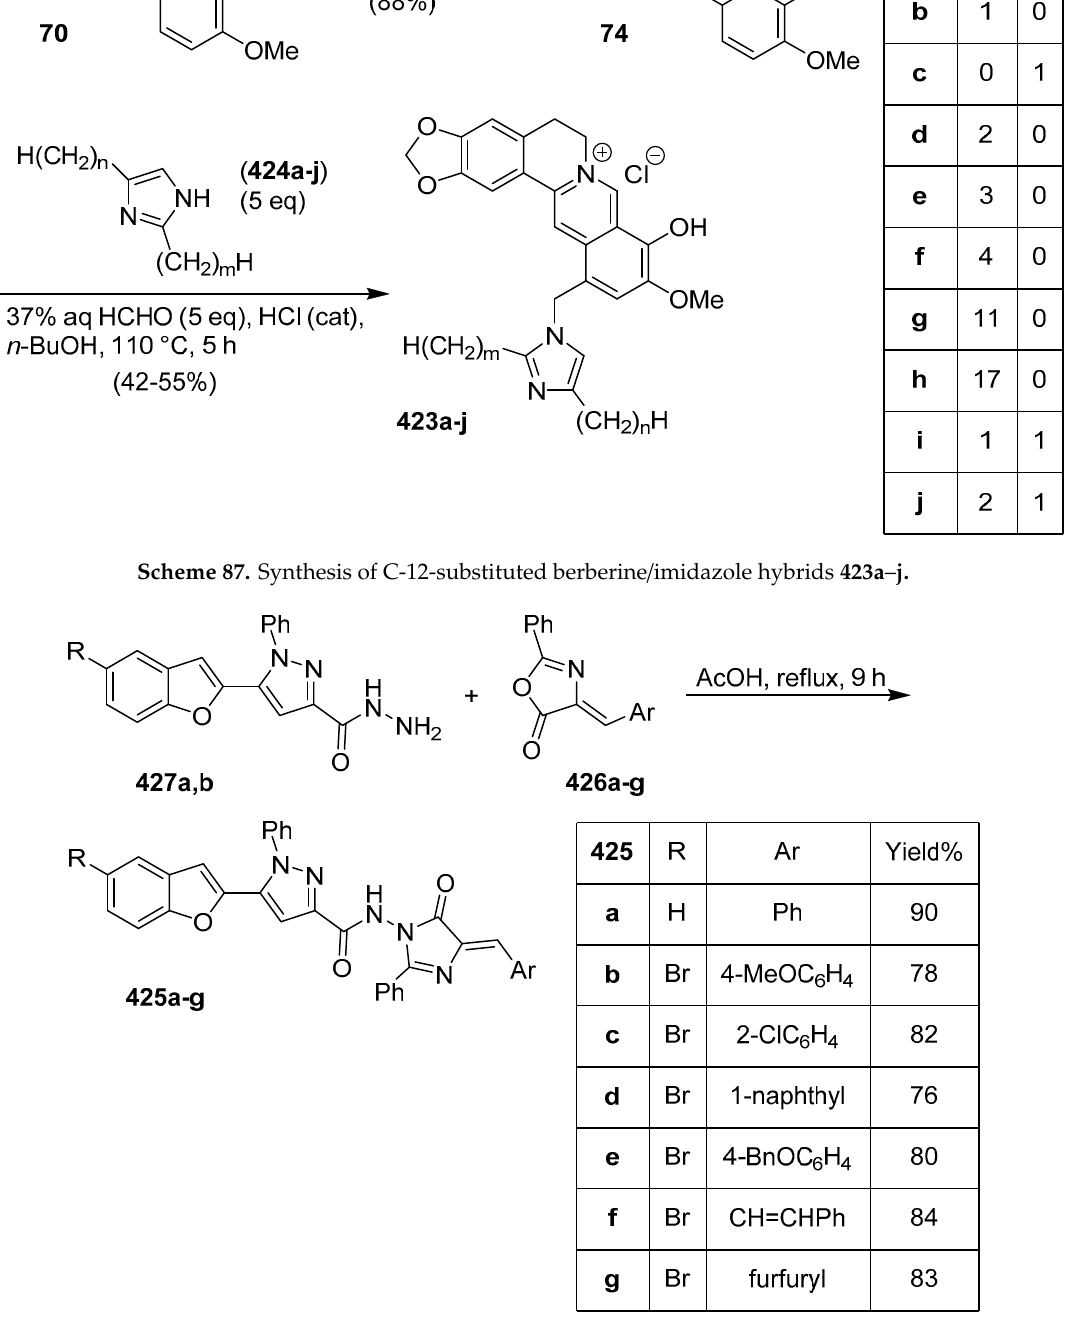
Scheme 88. Synthesis of N -(4-aryilidene-5-oxo-2-phenyl-4,5-dihydro-1 H -imidazol-1-yl)-5-(benzofuran- 2-yl)-1-phenyl-1 H -pyrazole-3-carboxamides 425a –